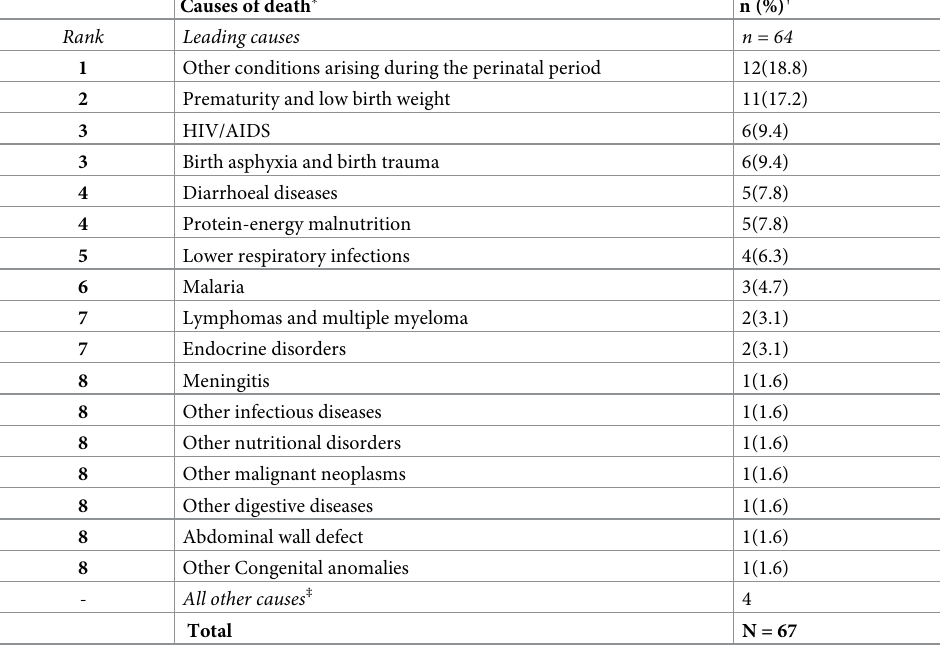
� Data for children overlap with data presented in Table 2 † Column percentages ‡ Not ranked or included in the